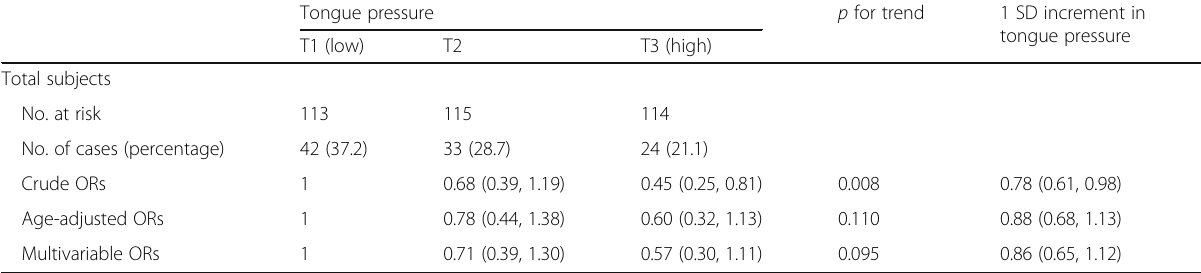
Table 3 Odds ratios (ORs) and 95% confidence intervals (CIs) for subclinical carotid atherosclerosis Tongue